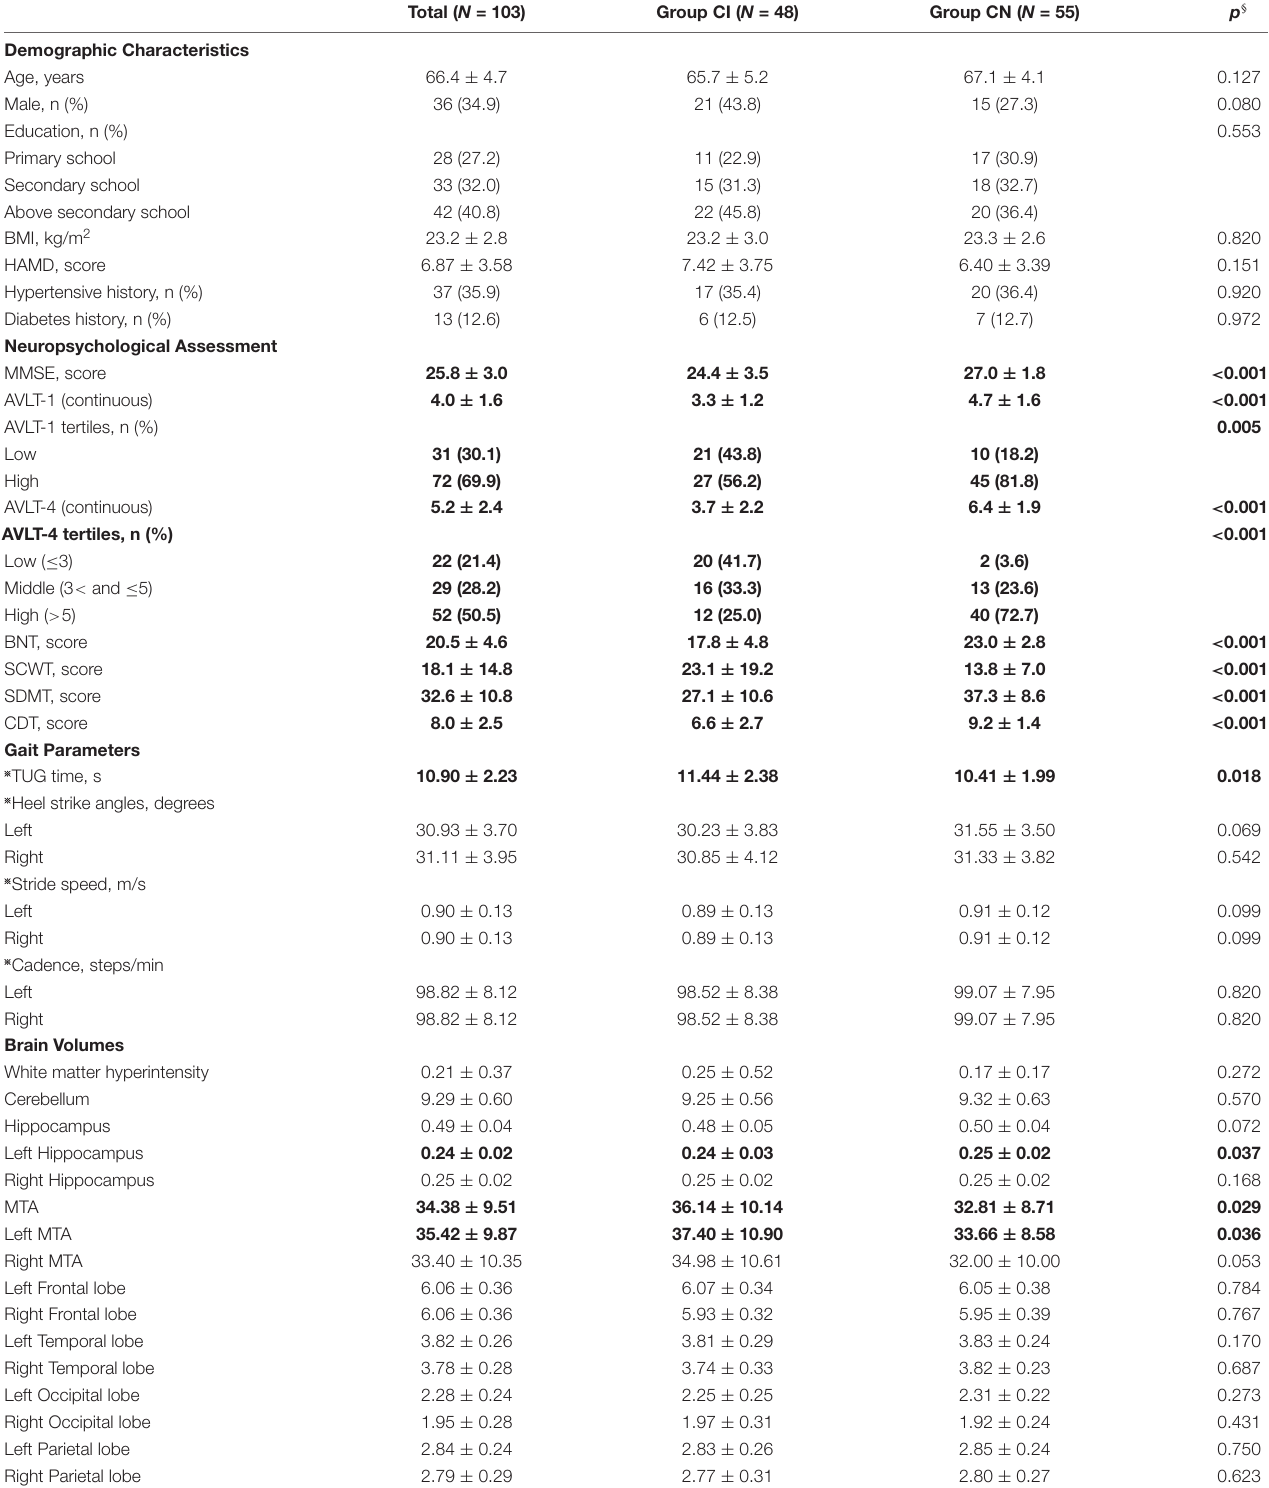
TABLE 1 | Characteristics of